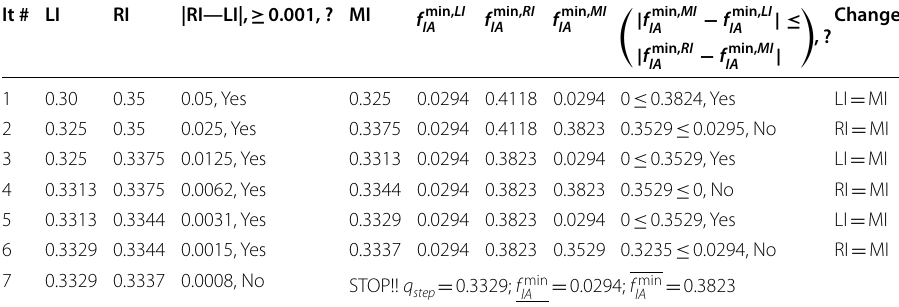
Table 1 Execution of the Jump Zone Analyzer binary search algorithm on the jump zone for the karate club